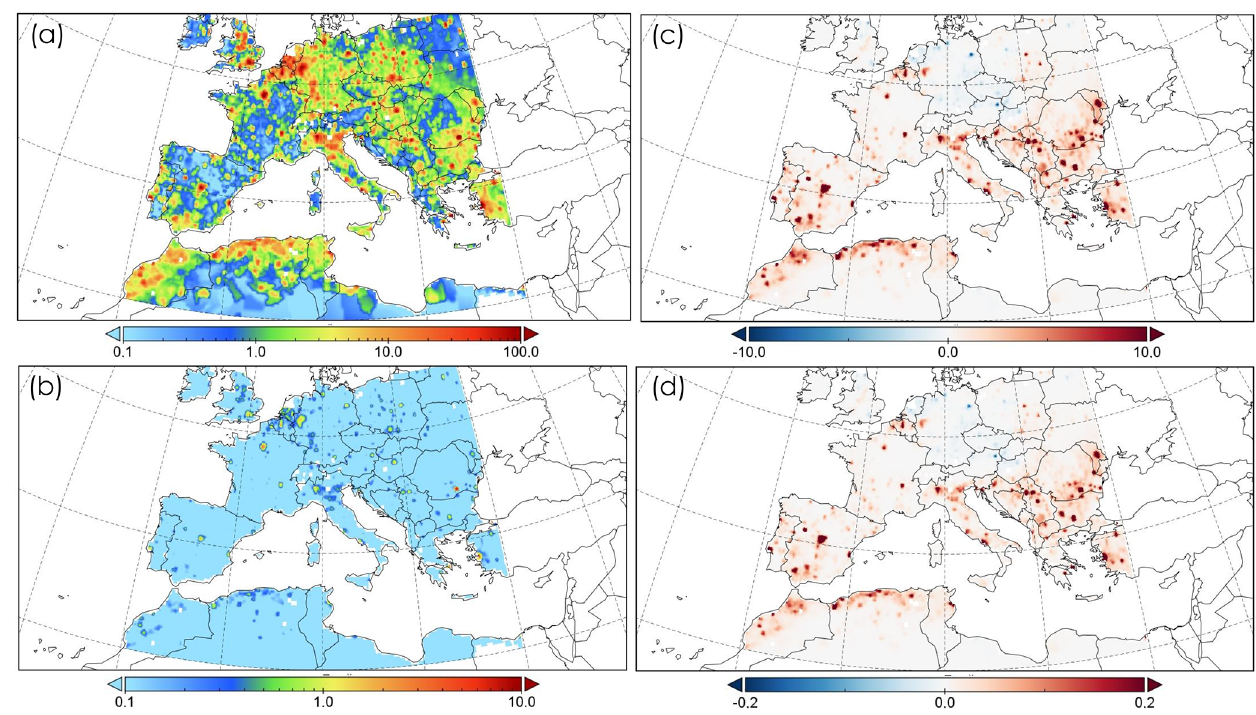
Figure 6. (a) Present cases of lung cancer (LC) and (b) associated costs, in millions of euros. (c) Changes projected in RHA cases and